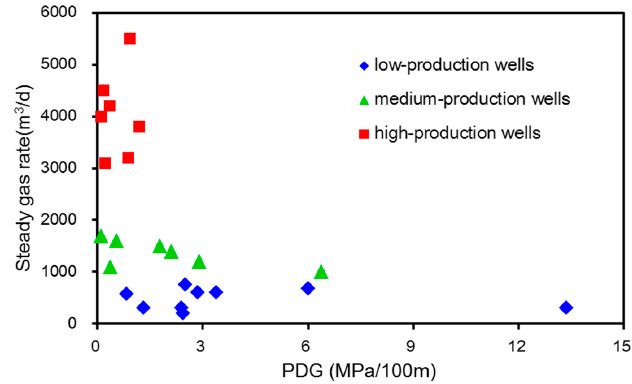
Figure 9. The relation between PDG and steady gas rate in water drainage stage.